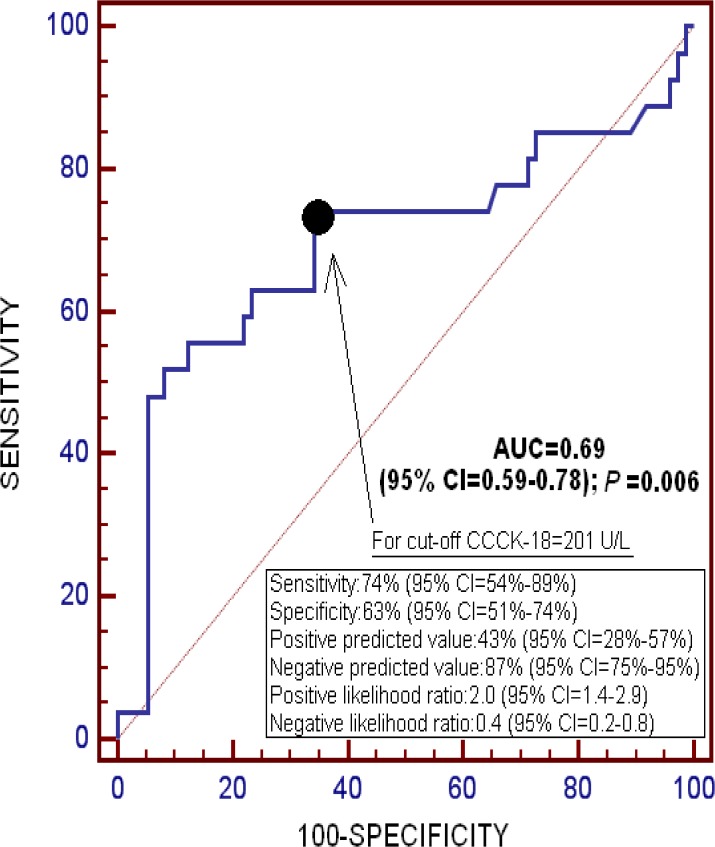
Receiver operating characteristic analysis using serum caspase-cleaved cytokeratin (CCCK)-18 levels as a predictor of mortality at 30 days.